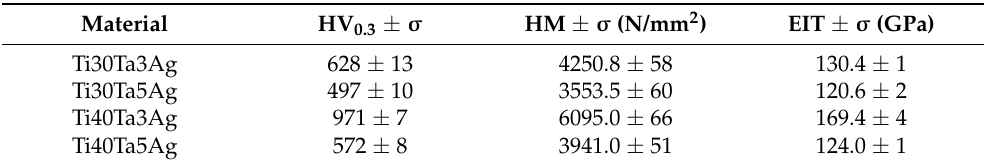
Figure 4. The nanoindentation (load-displacement) curves. Table 2. The mechanical properties of the Ti-Ta-Ag bulk alloys; the Vickers hardness (HV 0.3 ), Martens hardness (HM), and Young’s modulus (E).